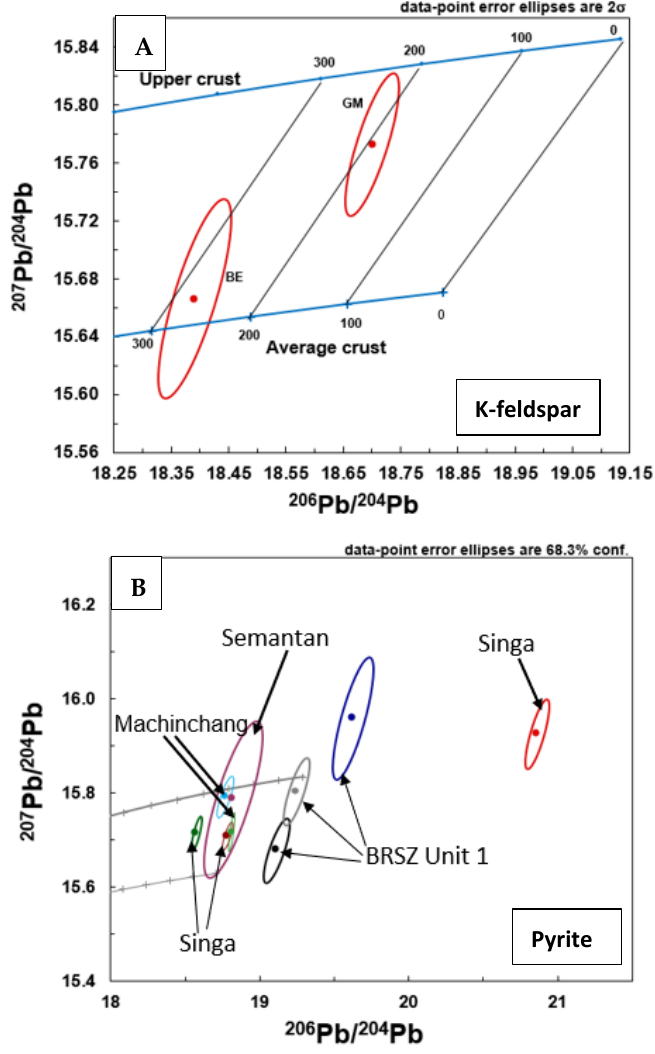
Figure 12. Lead isotope composition. ( A ) Lead isotope composition on K-feldspar from selected ilmenite-series granitic rocks cropping out in the Gua Musang (GM) and the Bentong area (BE). Red ellipses represent the two populations. The Gua Musang area is where most orogenic gold deposits such as Selinsing, and Tersang deposits are found. This graph was adapted from the model of [57]. The BE data plot is close to the average crust which is referred to as the subduction line. However, the GM data cluster below but close to the upper crust line. The 200 Ma Pb-Pb model age line transects the ellipse for the GM data; whereas the 300 Ma Pb-Pb model age line appears off-trend across the ellipse of the BE data. The results of the Pb isotopic composition in K-Feldspar are shown in Table S2. Abbreviation Fm means formation. ( B ) Pyrite Pb isotope composition on pyrite from the Machinchang, Semantan, BRSZ Unit 1, and Singa Formations. The data represent the background Pb isotopic composition compared to the Pb isotopic composition of ore-hosting pyrites at the Selinsing and Tersang gold deposits. The results of the Pb isotopic composition in pyrite are shown in Table S3.